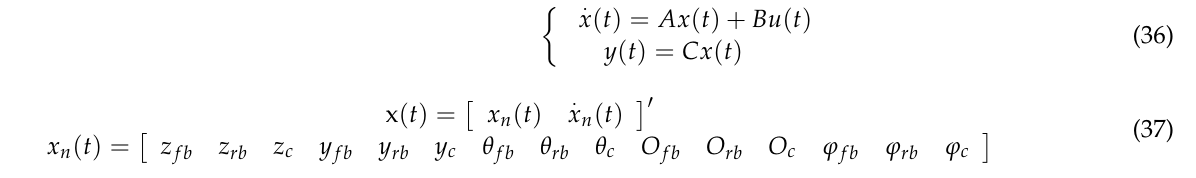
( b ) Lateral Figure 16. Guideway irregularity in the vertical/lateral direction.